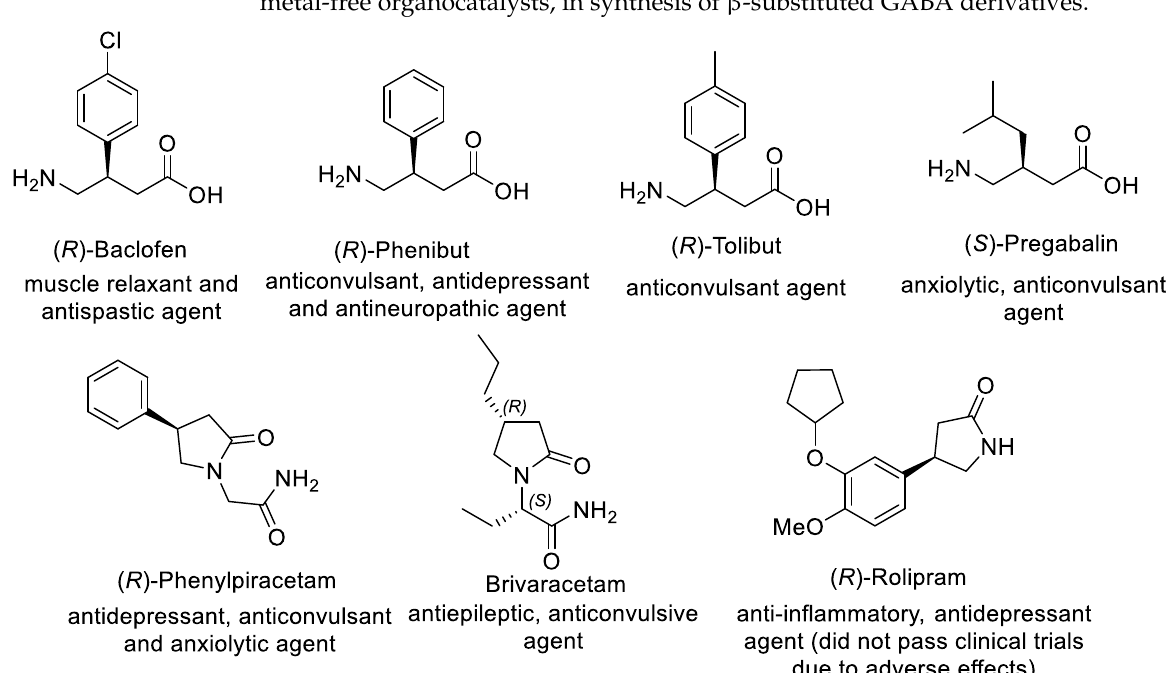
Figure 1. Representative β -substituted GABA derivatives with clinical applications.